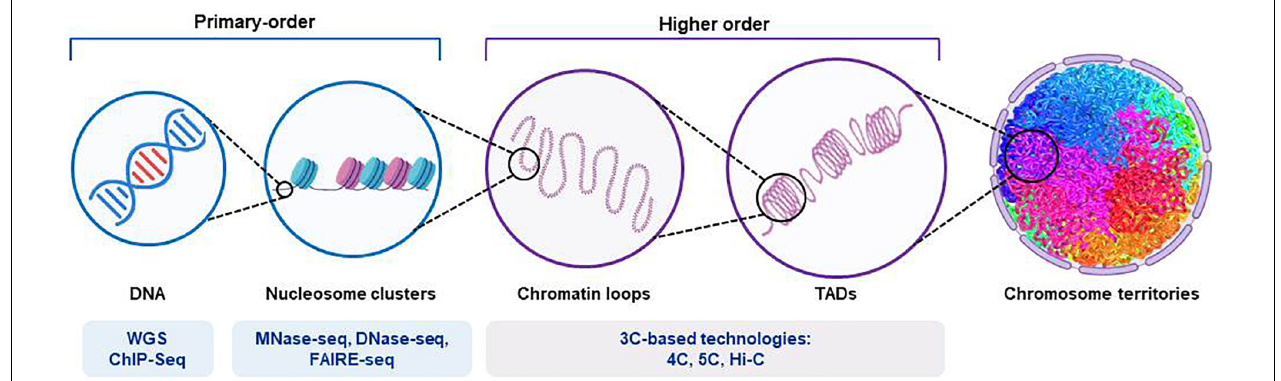
FIGURE 2 | Representation of the structure of chromosomal DNA and the technical procedures for the assessment of chromatin hierarchy. The diagram shows the main features of the organization of chromatin, from those of higher order to those of primary order. The different next-generation-sequencing-based techniques used for each order degree are shown. Whole-genome sequencing (WGS) applications allow identification of both coding and non-coding regulatory variants. Chromatin immunoprecipitation sequencing (ChIP-seq) provides identification of binding sites of DNA-associated proteins, which can be used to map the global binding sites for any given protein (e.g., transcription factors). Endo-exonuclease sequencing (MNase-seq) allows identification of closed chromatin by using an endo-exonuclease to cleave the linker DNA between nucleosomes. DNase I endonuclease sequencing (DNase-seq) identifies open chromatin regions, as accessible regions of the genome are hypersensitive to this activity. Sequencing through formaldehyde-assisted isolation of regulatory elements (FAIRE-seq) is a similar method that identifies open regions of the genome. The chromosome conformation capture (3C)-based technologies (e.g., 4C, 5C, and their variants [Hi-C]) incorporate next-generation sequencing and can provide quantitative measures for intra ( cis )-chromosomal and inter ( trans )-chromosomal interactions. TADs, topologically associated